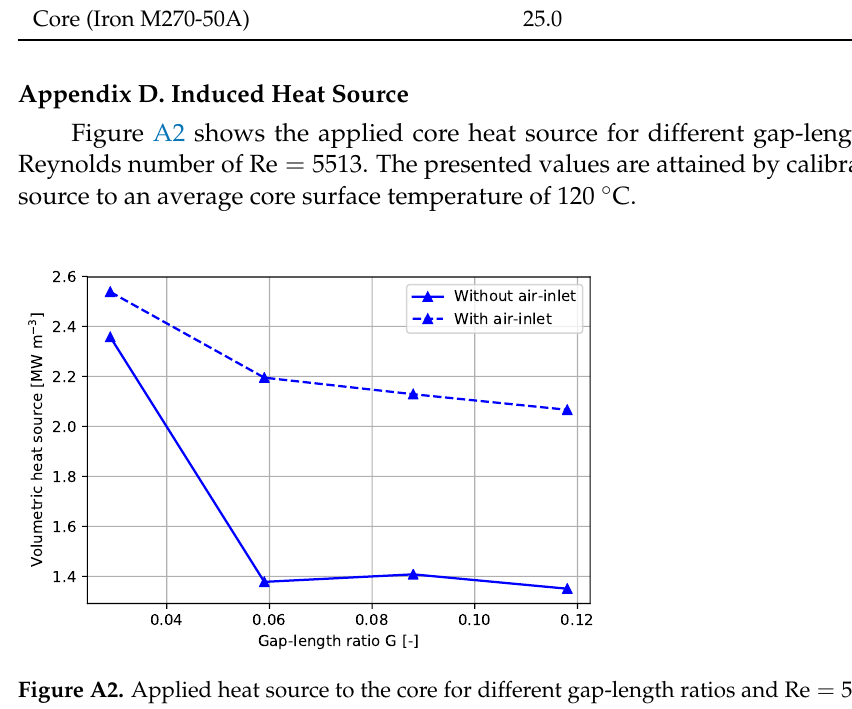
Figure A2. Applied heat source to the core for different gap-length ratios and Re = 5513. All values correspond to an average core surface temperature of 120 ◦